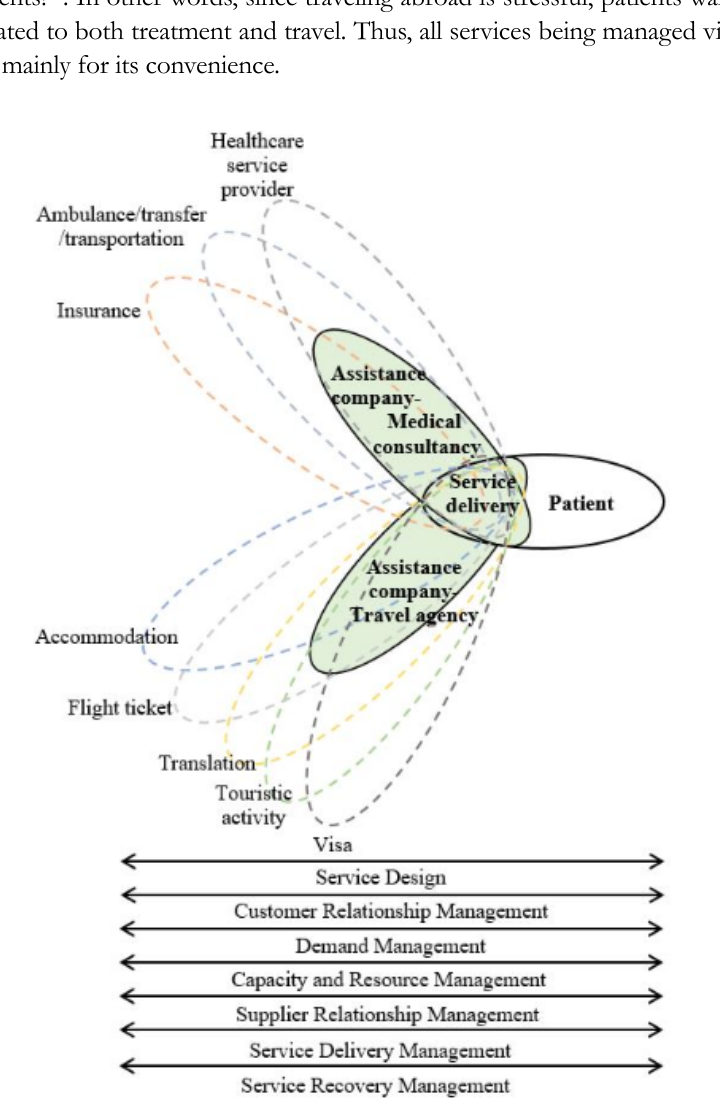
Figure 3. Second version of the proposed MTSSC